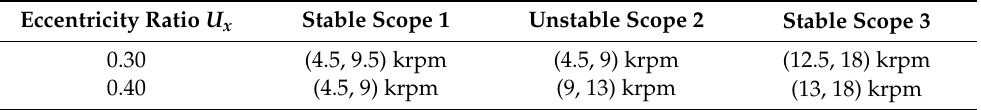
Table 2. Unstable Rotation Speed with Di ff erent Eccentricity